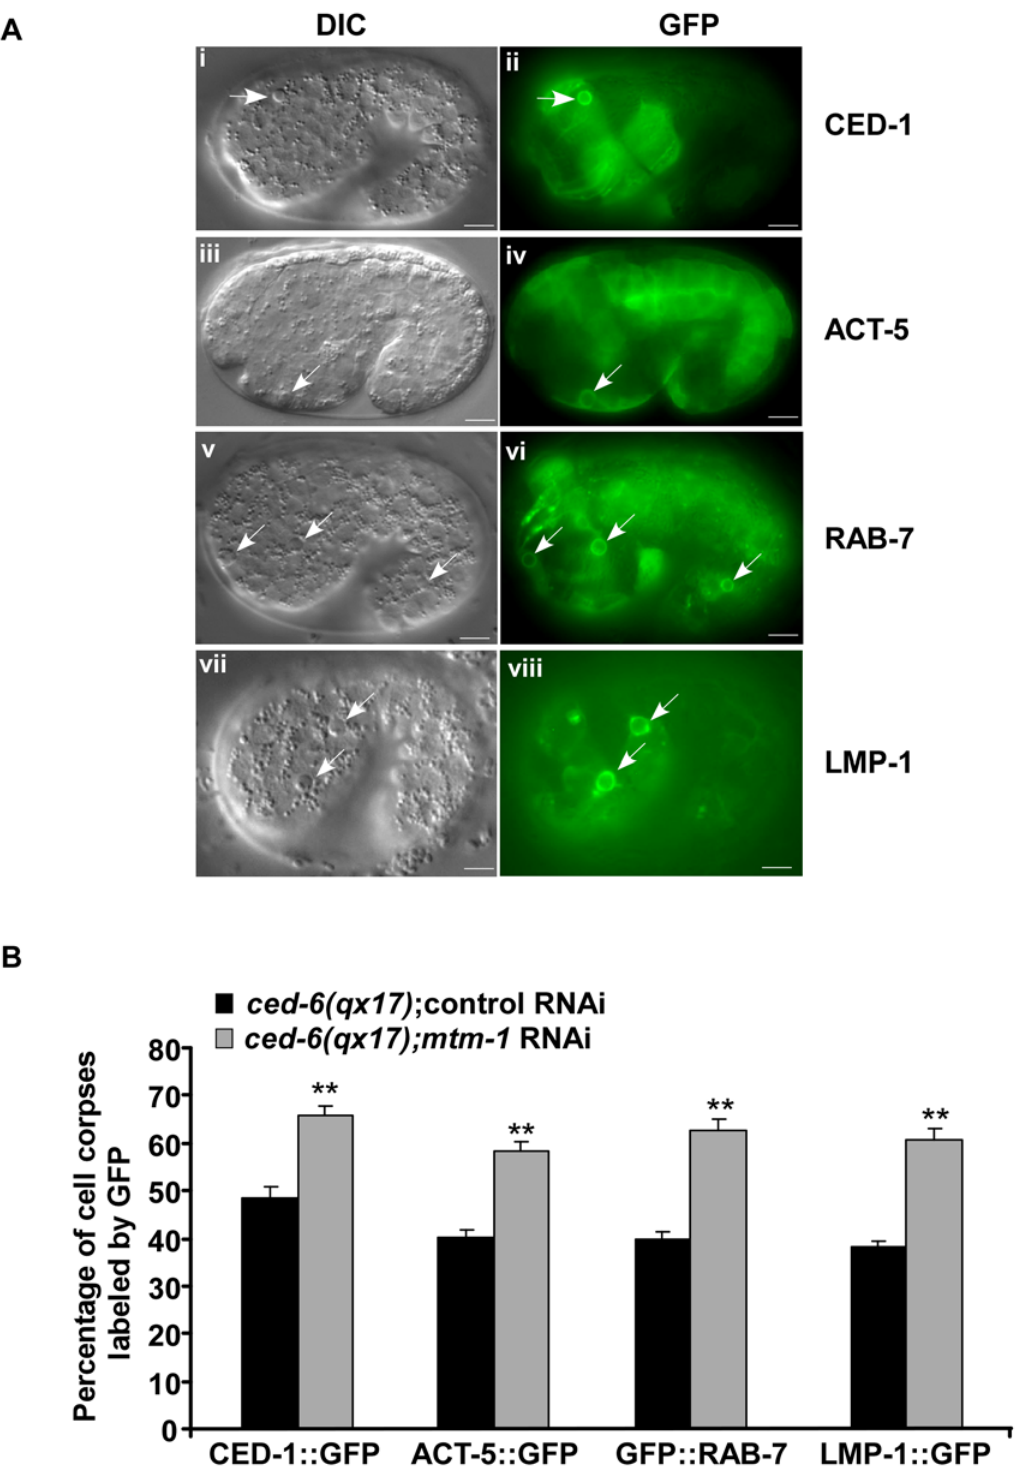
Figure 3. Loss of mtm-1 function promotes the internalization of cell corpses. (A) DIC and fluorescence images of wild-type embryos expressing CED-1::GFP (i, ii), ACT-5::GFP (iii, iv), GFP::RAB-7 (v, vi) or LMP-1::GFP (vii, viii) are shown. Cell corpses surrounded by GFP are indicated by arrows. Bars, 5 m m. (B) The percentage of cell corpses encircled by CED-1::GFP, ACT-5::GFP, GFP::RAB-7 or LMP-1::GFP was quantified in ced-6(qx17) embryos treated with either control (black bar) or mtm-1 RNAi (gray bar). At least 17 1.5-fold stage embryos were scored; error bars indicate s.e.m. Unpaired t tests were performed to compare the data. ** P , 0.0001.